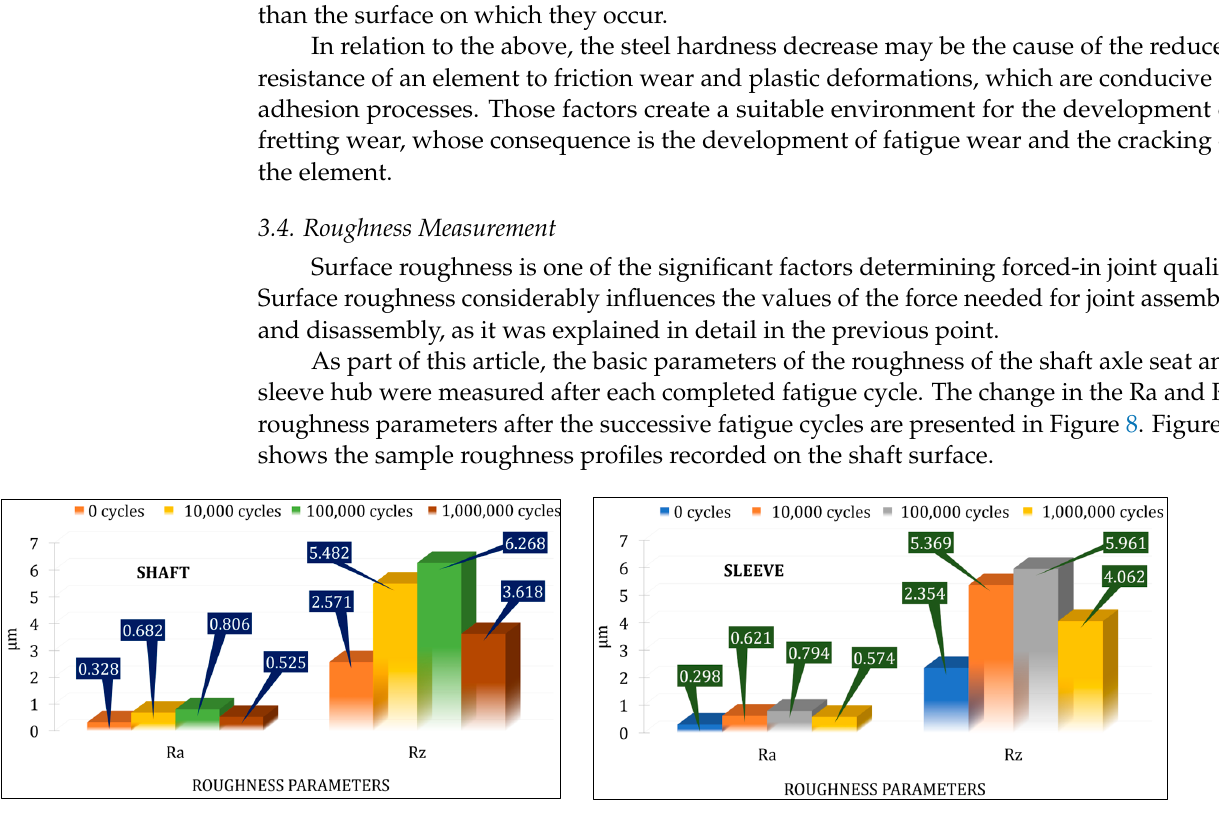
Figure 8. Shaft and sleeve roughness parameters.